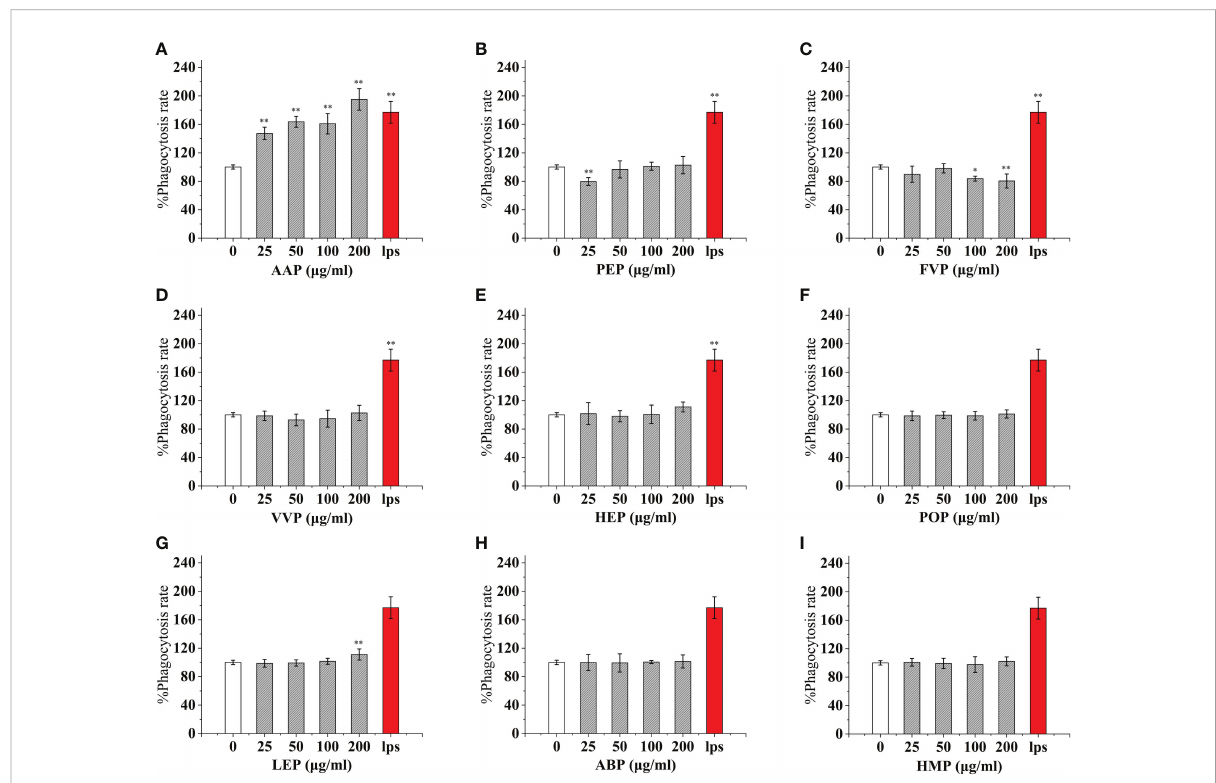
FIGURE 4 Phagocytosis of nine common edible mushroom proteins on RAW 264.7 cells. AAP (A) , PEP (B) , FVP (C) , VVP (D) , HEP (E) , POP (F) , LEP (G) , ABP (H) and HMP (I) ) on the phagocytosis of RAW 264.7 macrophages. Data are expressed as mean ± SD (n = 5). *P <0.05, **P <0.01, compared with the control